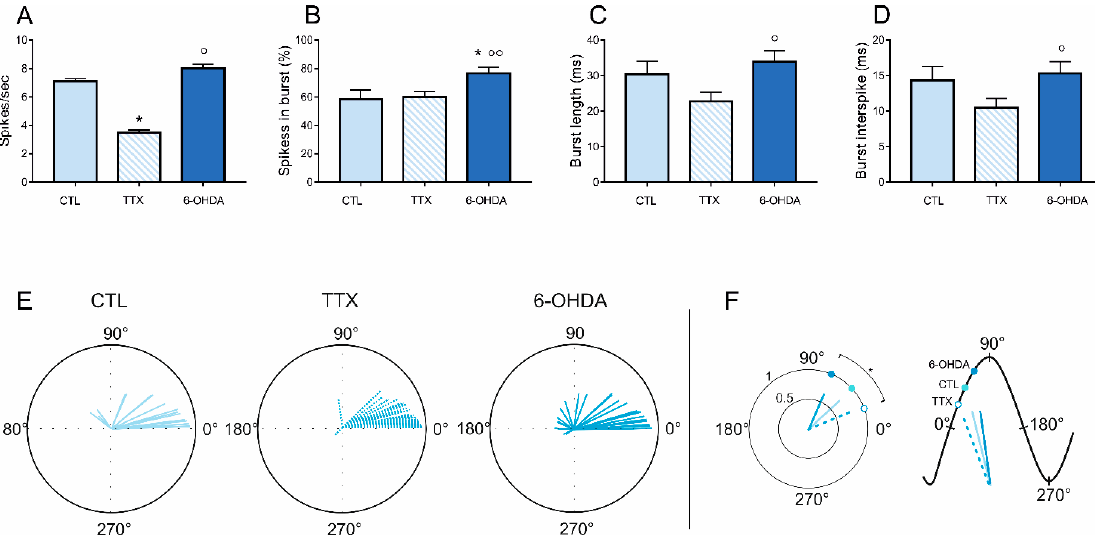
Figure 2. ( A – D ) Firing rate and pattern of the MTh in CTL, during tetrodotoxin (TTX) infusion and in 6-hydroxydopamine (6-OHDA)-lesioned rats. * p < 0.05. ( E , F ). Phase correlation analysis. ( E ) MTh circular plots of the phase-locked firing of the MTh neurons in control, acute and chronic DA depletion states. The vectors of the preferred firing of individual neurons are shown as lines radiating from the center. The last smaller circular plots show the mean vector for the preferred phases of neurons in each group. ( F ) The histograms on the right show the vector lengths and phase angle comparisons between MTh (blue) in control (dark color), acute (dashed color) and chronic (light color) DA depletion states. On the left, the representation of hypothetical cortical slow oscillation comparing the phase angle